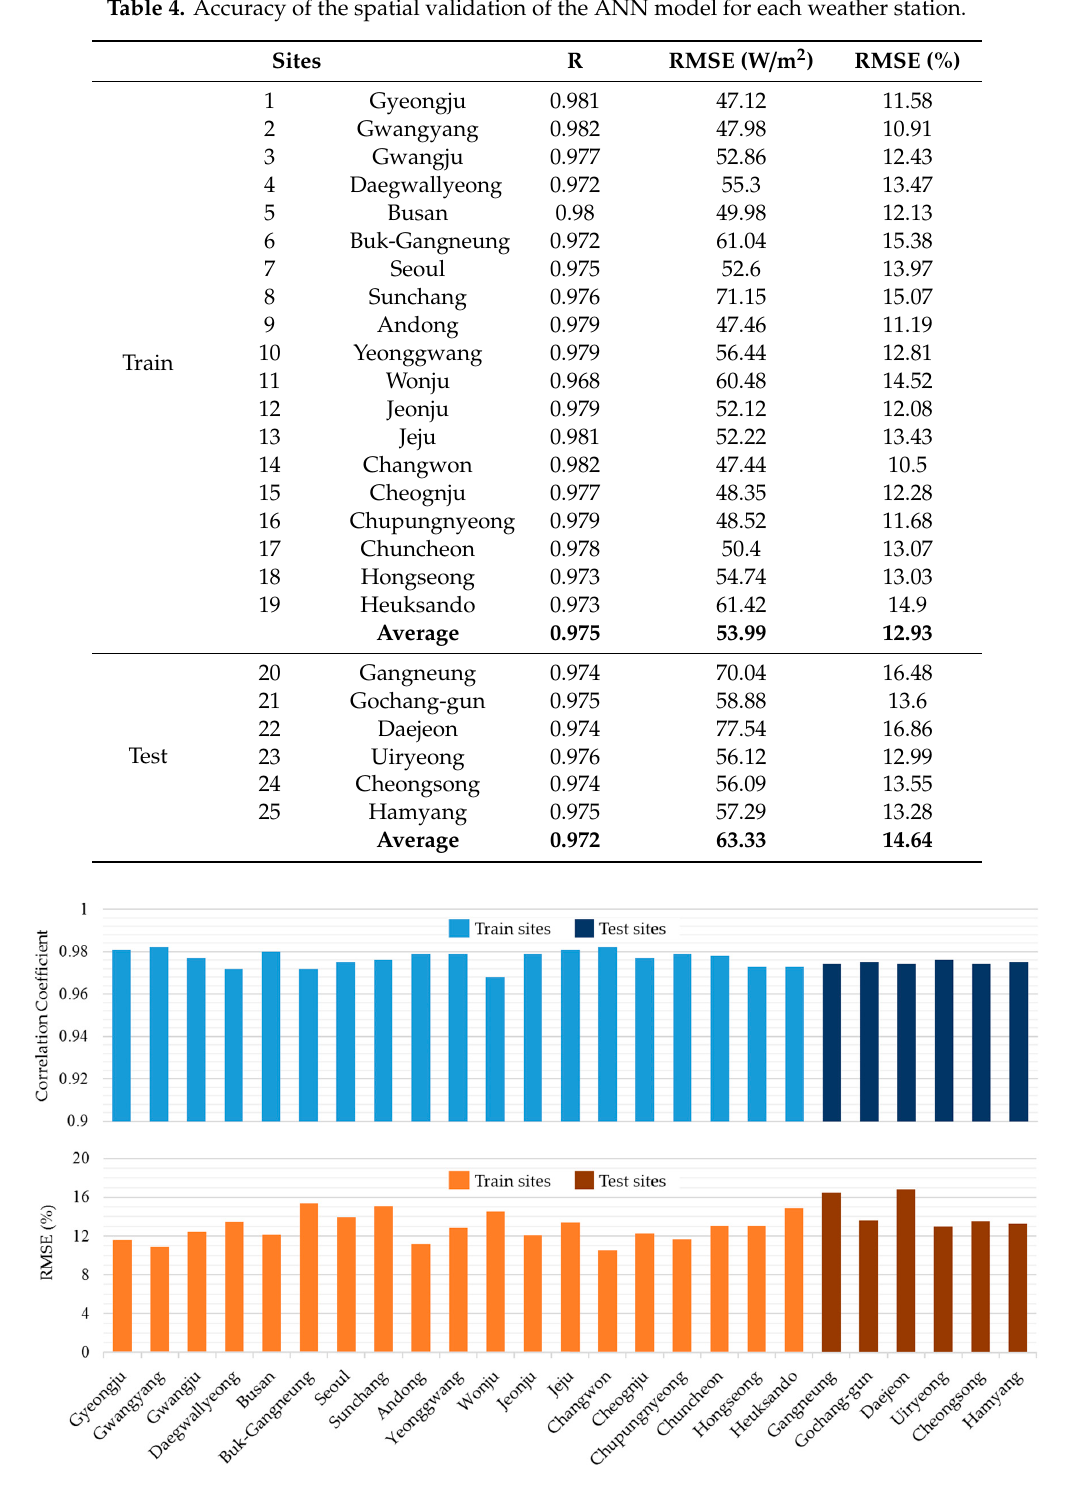
Figure 9. Accuracy (R and rRMSE) of the spatial validation of theANN model for each weather station.